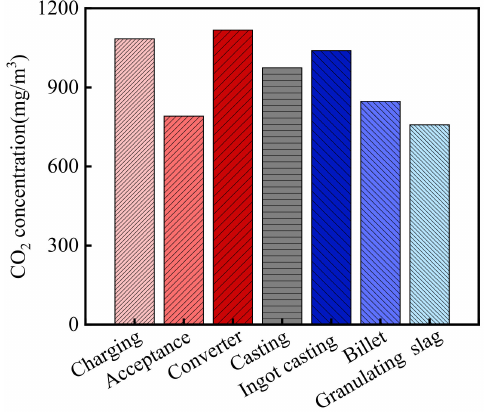
Figure 3. CO 2 concentration in the steelworks.